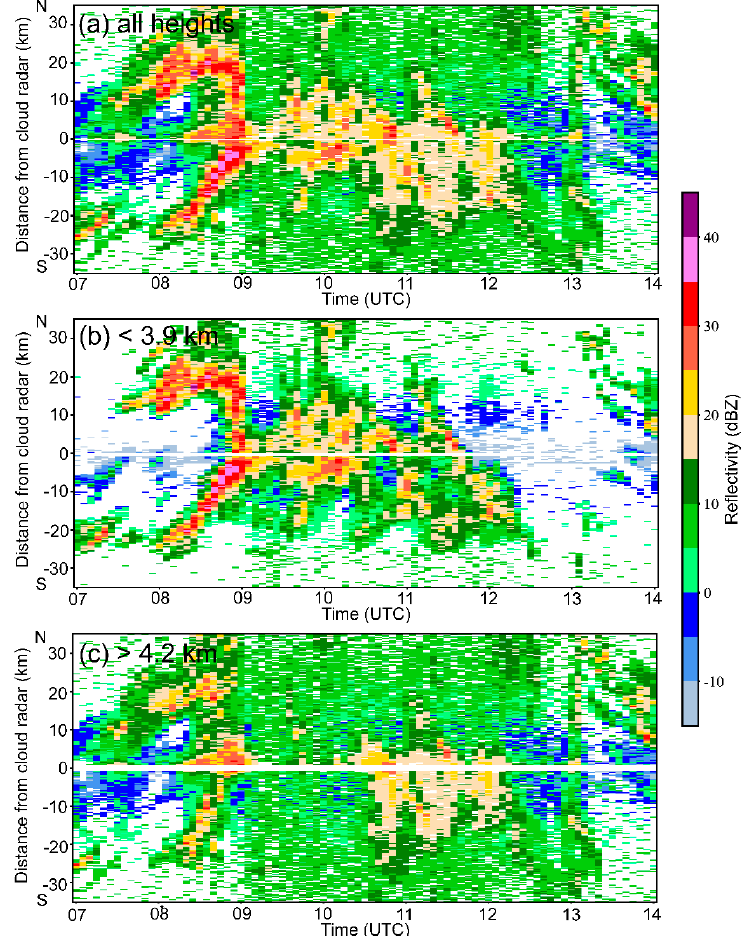
Figure 9. Temporal evaluation of the composite reflectivity measured by the cloud radar along the RHI cross − section for ( a ) all heights, ( b ) heights below 3.9 km, and ( c ) heights above 4.2 km. S and N on the y-axis indicate south and north of the cloud radar.